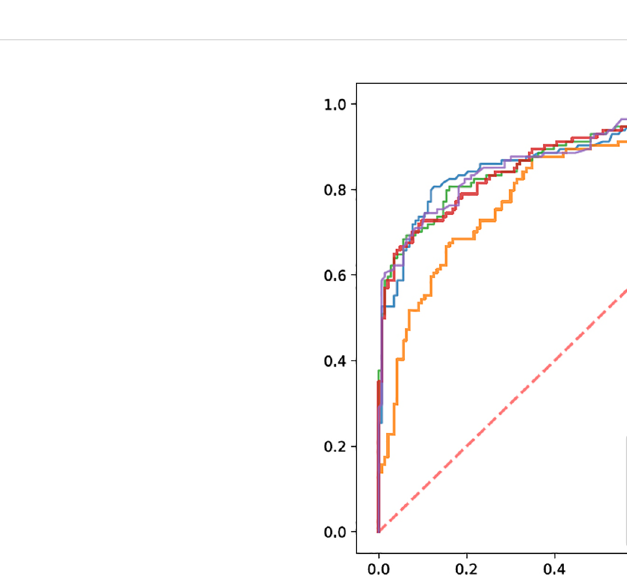
FIGURE 5 ROC of the EN HU , EN-PN HU , EN/PN HU , EN-EM HU , and EN/EM HU for the diagnostic ef fi cacy of LNs metastasis in PTC.